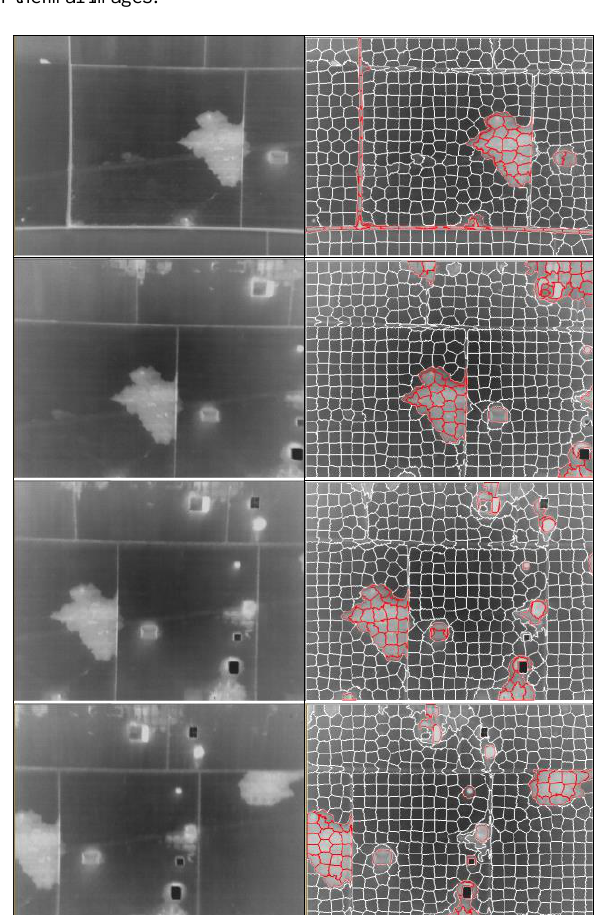
Figure 8: Relative thermographic calibration results of a strip of four thermal